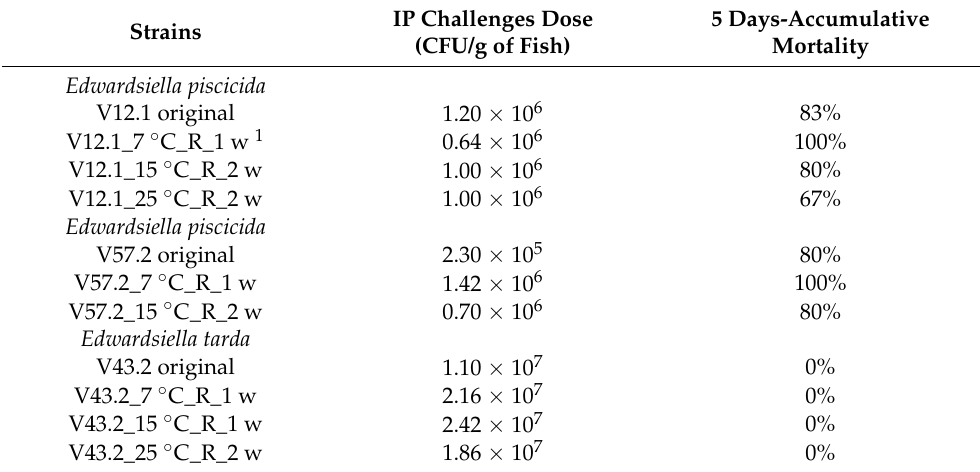
5 Days-Accumulative Mortality